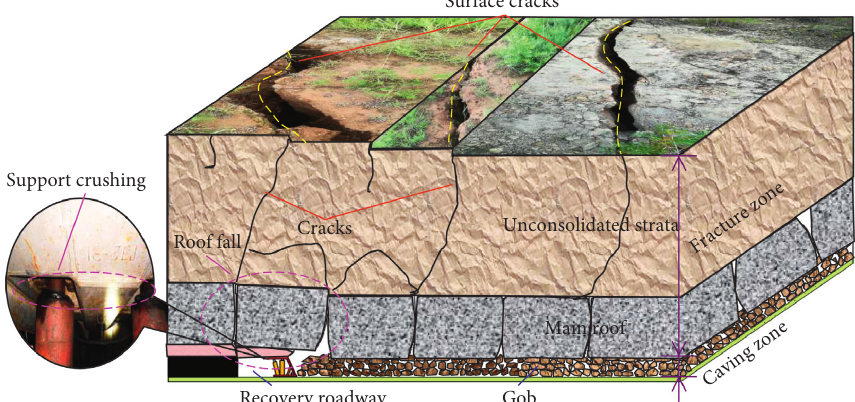
Figure 1: Roof and support damage during the extraction of